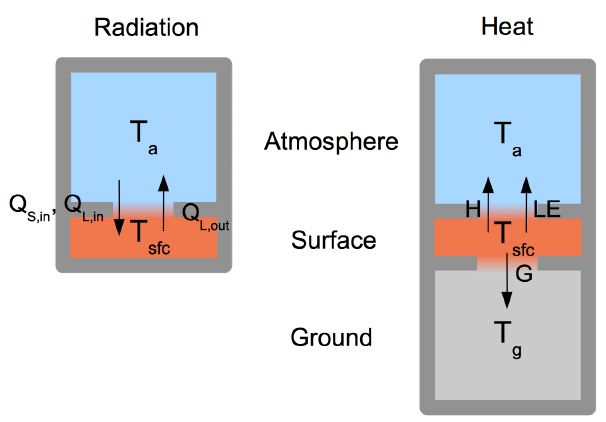
Fig. 1. Schematic view of the (left) radiation and (right) heat fluxes considered in the entropy